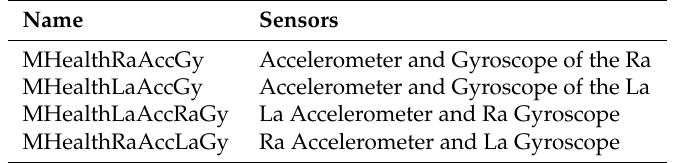
Table 3. Data sets obtained from the data of the IMUs of the Mhealth data set.